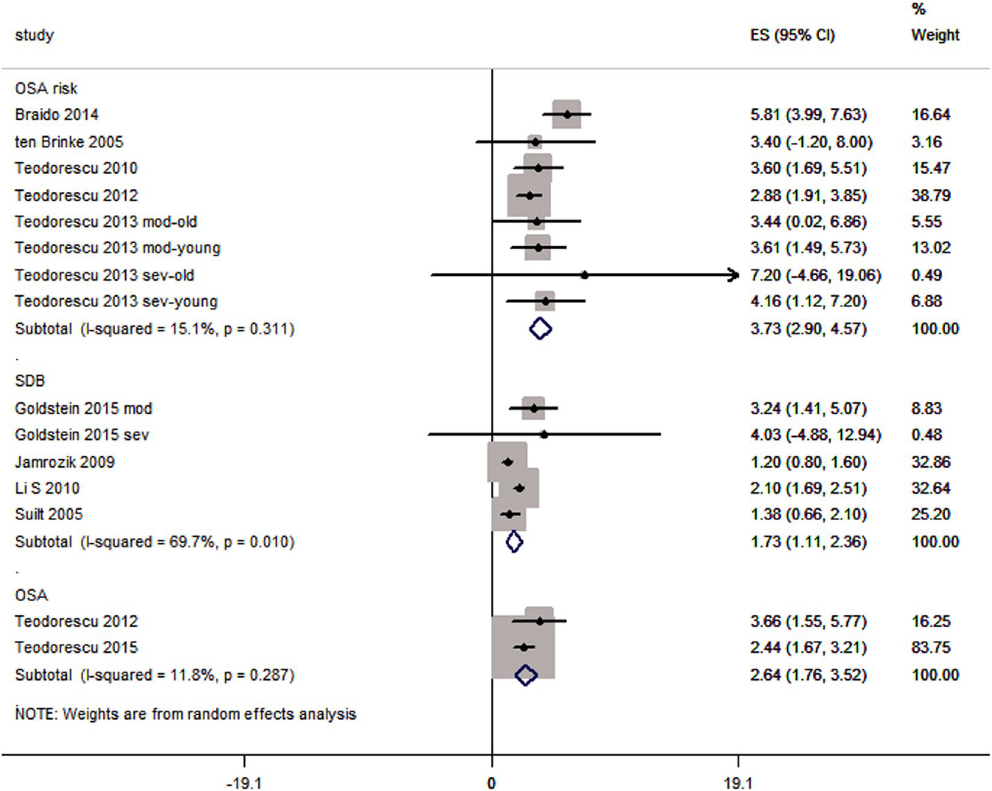
Figure 3. Forest graph showing the meta-analysis of odds ratios reported in individual studies with regards to OSA, OSA risk and SDB subgroups. Abbreviations in study identity: mod, moderate asthma, sev, severe asthma.